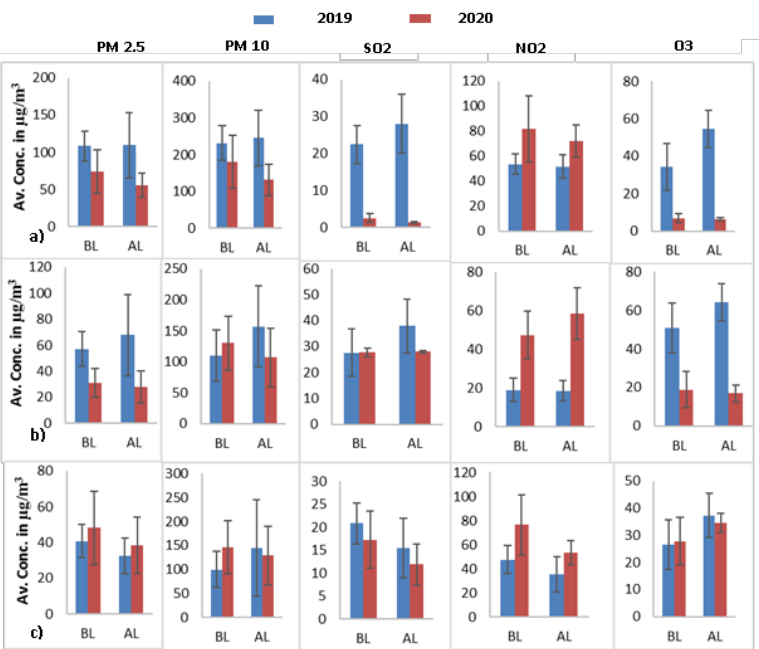
Figure 2. Concentration of PM , PM , SO , NO and O before lockdown period (BL) and during 2.5 10 2 2 3 lockdown period (AL) in 2020 compared to same period in previous year, i.e., in 2019 at (a) Jahangirpuri (b) Sonipat and (c) Panipat (BL - before lockdown (4 th March - 24 th March,2020); AL - during lockdown period (25 th March - 26 th May, 2020) - lockdown phases 1, 2 and